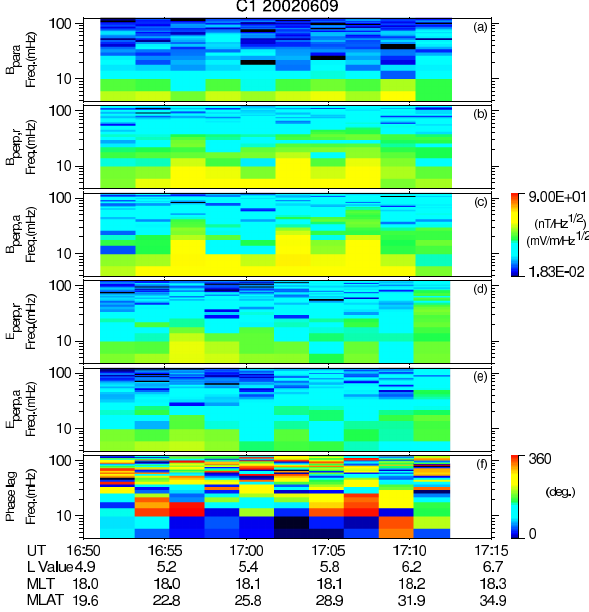
Fig. 13. Frequency-time spectra calculated using C1 data between 16:50 and 17:15UT on 9 June 2002. Each panel shows the same quantity as Fig.